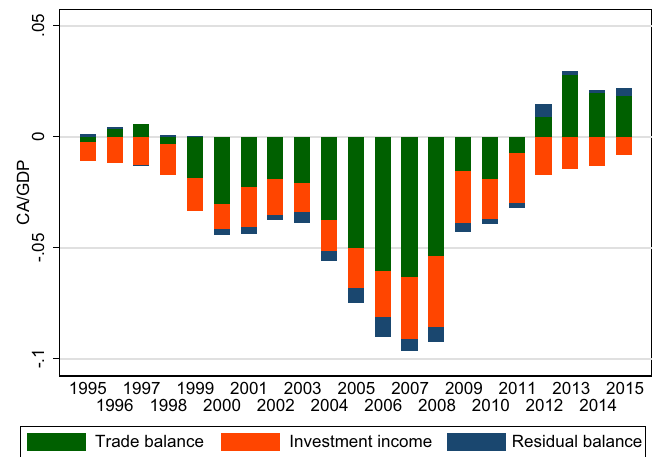
Fig. 6 Trade and investment income balance. Notes. This plot shows the decomposition of the Spanish currentaccountbalanceintothebalanceoftrade(recordingnetexportsofgoodsandservices),theinvestment income balance (capturing the income received by Spanish residents on their foreign assets minus the payments made on their stock of external liabilities), and the residual balance (reflecting net labour